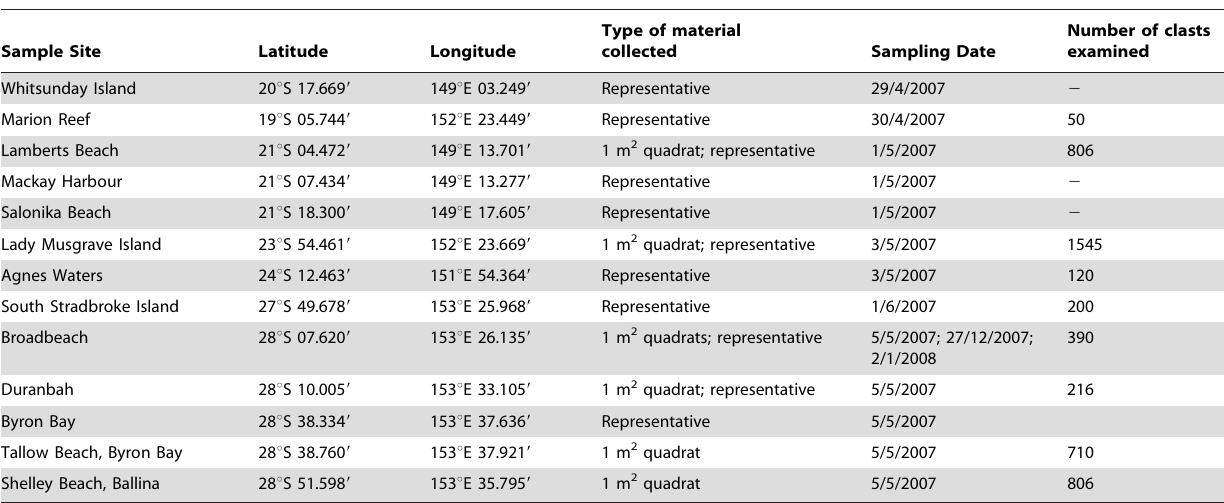
Table 1. Pumice strand sample sites, Eastern Australia.